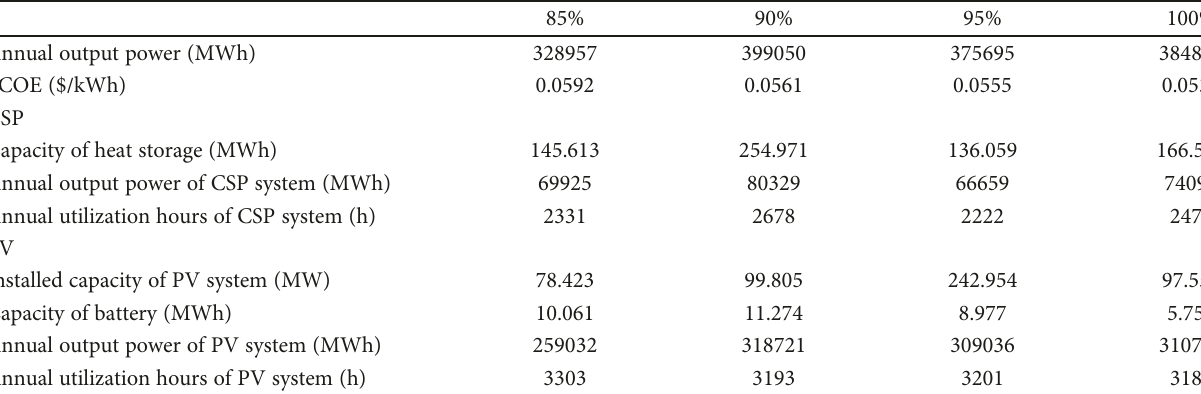
Table 8: Impact of rated output power on CSP-PV system.